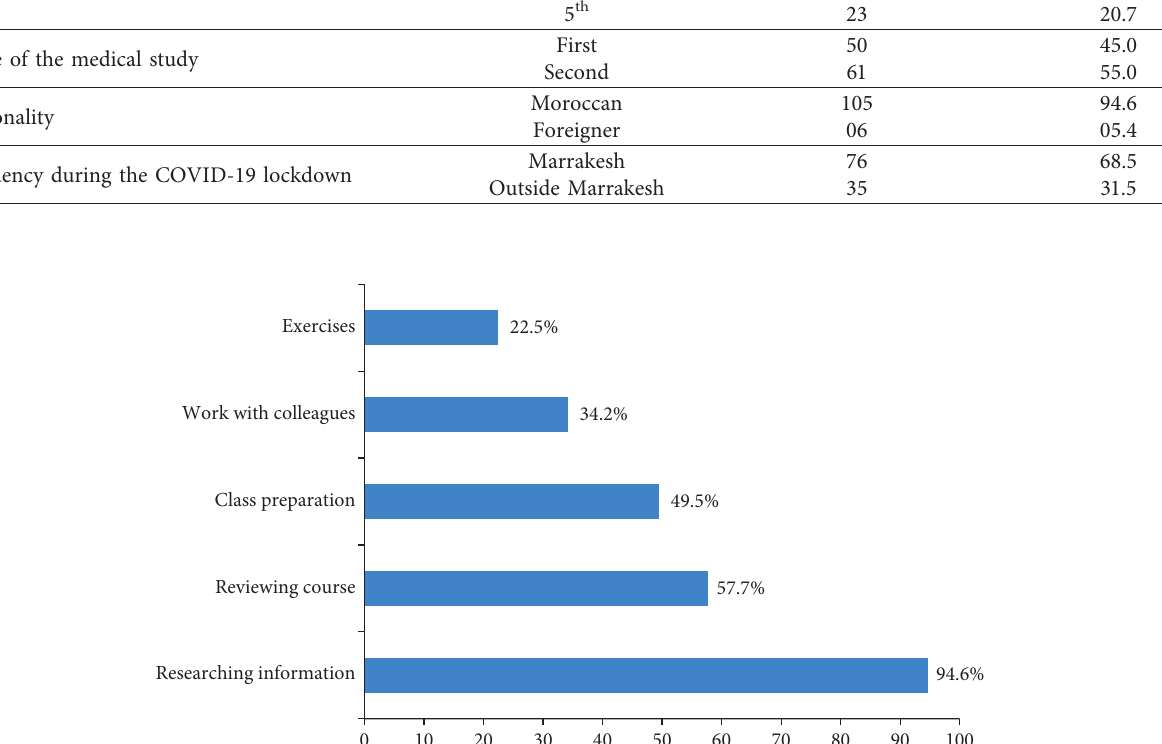
Figure 1: Description of the students’ use of the virtual technologies during their medical